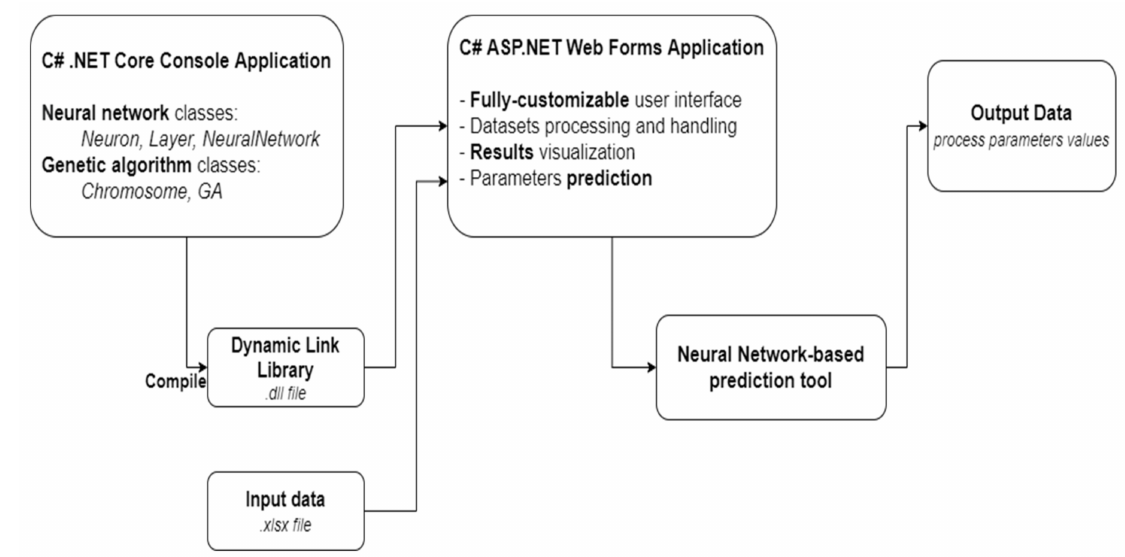
Figure 8. Software application architecture.